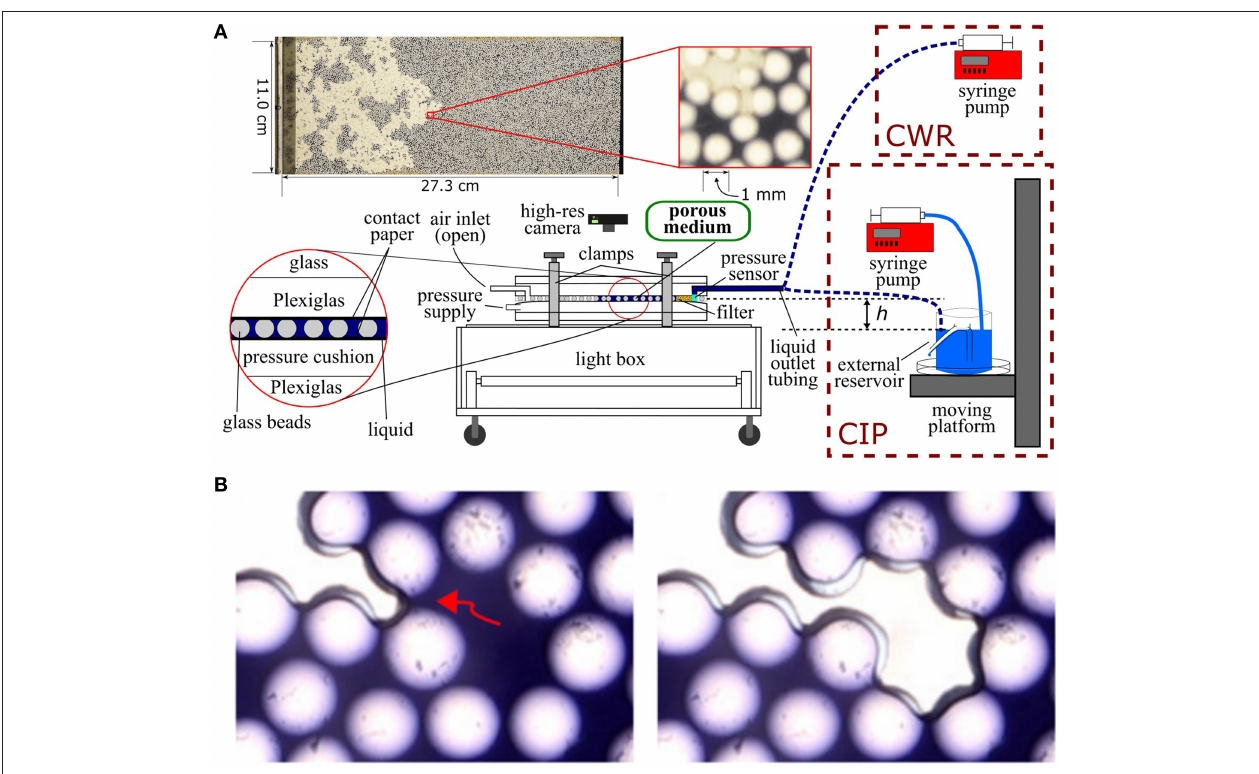
FIGURE 1 | (A) Diagram of the experimental setup, see text. The liquid outlet on the right is connected to one of the modules shown in the dashed squares, depending on the choice of the boundary condition (controlled imposed pressure—CIP, or controlled withdrawal rate—CWR). In the CWR case, the outlet is just connected to the syringe in the pump, and in the CIP case, it is connected to the external reservoir placed above the moving platform. On the top we show a typical image of the experiment and a detailed zoomed in section showing the structure of the porous network, the invading air phase (white) and the defending liquid phase (blue). (B) A typical pore invasion event, imaged with a macro lens. Air invades the defending liquid through the widest pore-throat available to the liquid-air interface at that time (marked by the red arrow on the left image). After the invasion, a new set of pore-throats becomes available to the interface. Adapted from Moura et al. [